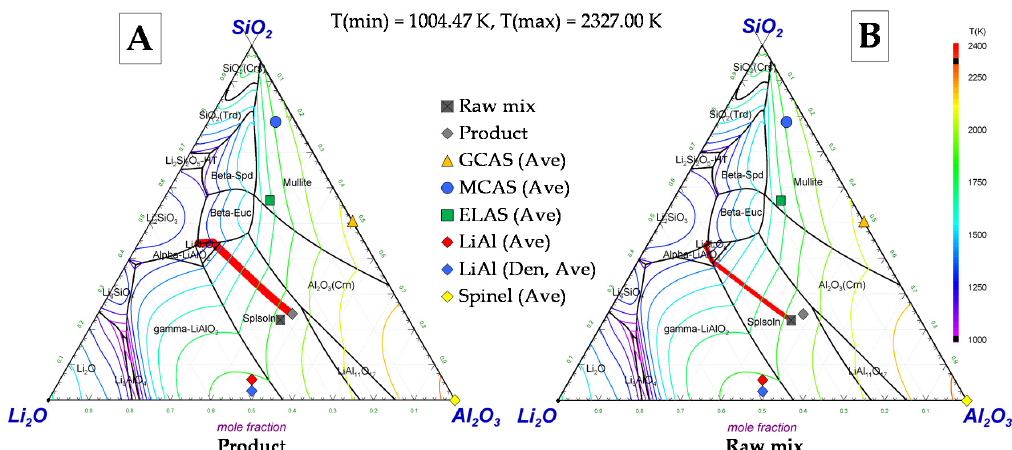
Figure 7. Calculated Li 2 O-Al 2 O 3 -SiO 2 liquidus projection at 1 atm total pressure based on [22] is shown. Red line, equilibrium solidification paths starting at the initial point of the “product” ( A ) and the “raw mix” ( B ). The initial points represent the respective component concentrations in the liquid phase. Isothermal lines are drawn in Kelvin at every 100 K. In this diagram, the average compositions of the single compounds, analyzed with EPMA at room temperature (see Tables 4, 5 and 6b), and the bulk chemistry of the “raw mix” and the “product” are presented.